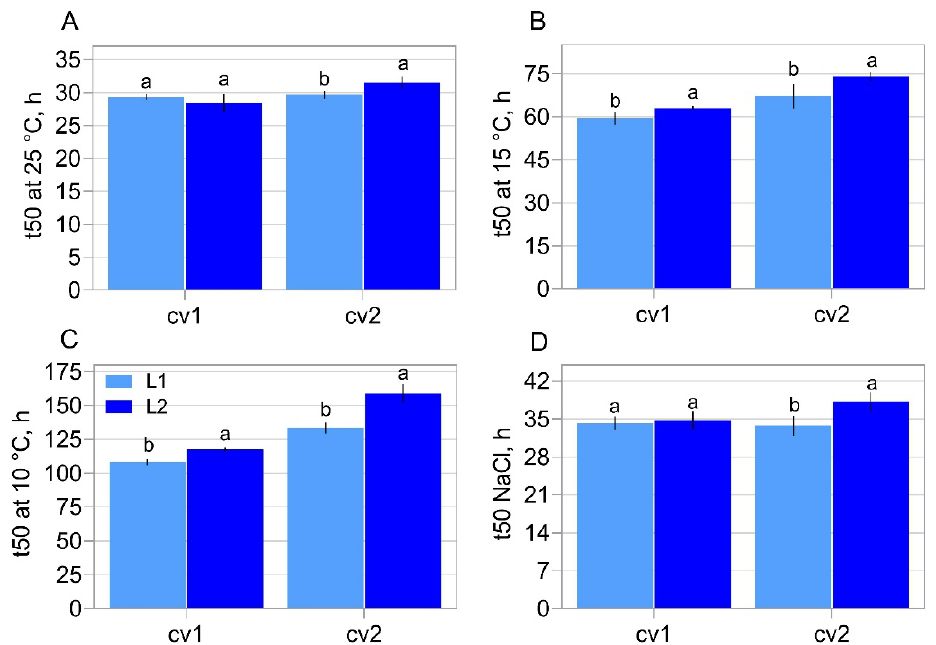
Figure 2. Time to reach 50% of root protrusion (t50) in two commercial cultivars (cv1-BRS133 and cv2-MG/BR 46 (Conquista)) and their respective seed lots (L1: lot 1 and L2: lot 2). t50 at 25 °C ( A ), 15 °C ( B ) and 10°C ( C ), and t50 in saline substrate at 100 mmol.L − 1 of NaCl ( D ). Different letters indicate a significant difference at the 5% probability level ( p < 0.05). Error bars show standard deviation ( n = 8).